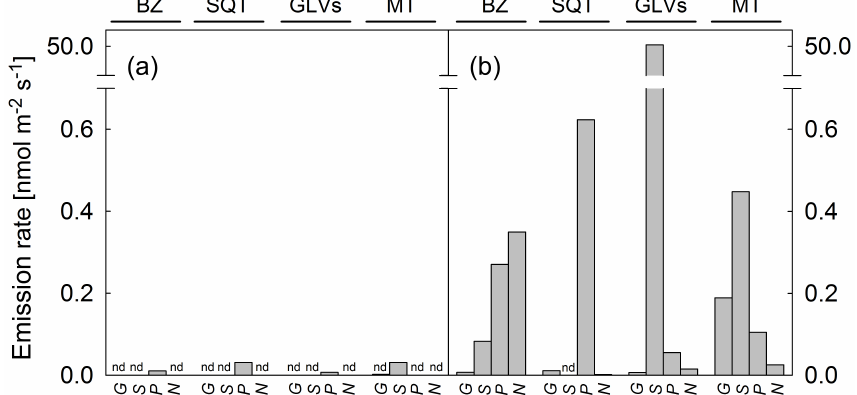
Figure 1. Example of stress-induced BVOC emissions (a) before and (b) after O 3 exposure in different plant model species from the laboratory study. Measurements were performed continuously throughout the day with a time resolution of approx. 76min as determined by the time resolution of a chromatographic run. Bars indicate daily mean of BVOC fluxes. The plant species that were used and the number of biological replicates ( n ) were G Gossypium hirsutum (cotton, n = 4); S Solanum lycopersicum (tomato, n = 7); P Populus × canescensis (Poplar, n = 17); and N Nicotiana tabacum (tobacco, n = 27). Emissions appeared as pulses lasting several days and also depended on stress intensity (Beauchamp et al., 2005). With respect to the classification into sBVOCs and cBVOCs, the results were always similar: BZs, SQTs, and GLVs were only emitted after stress application. For monoterpenes there were constitutive as well as stress-induced emissions. Data from the laboratory experiments in Jülich were only taken for classification as sBVOCs and cBVOCs, respectively. Abbreviations are as follows: BZs benzenoids; SQTs sesquiterpenes; GLVs green leaf volatiles; MTs monoterpenes; nd not